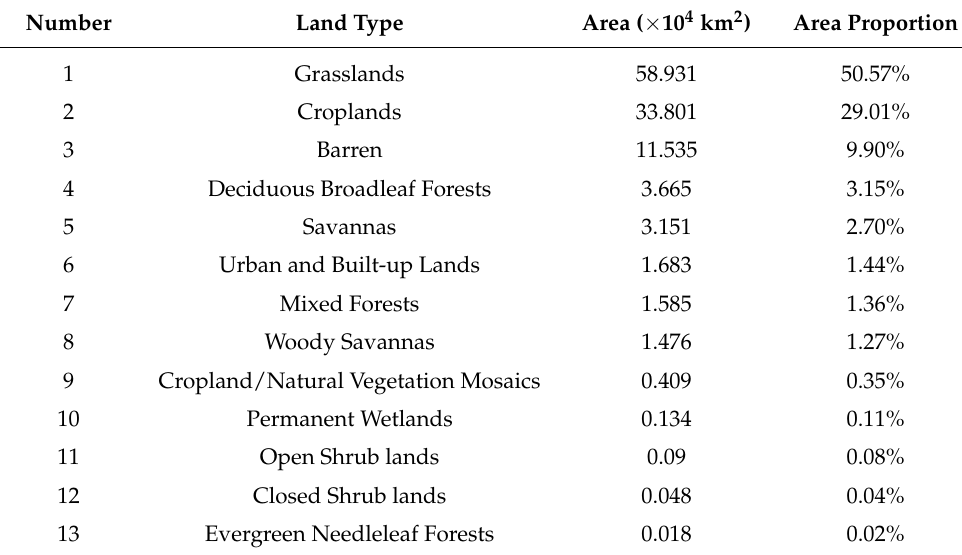
Figure 1. The Yellow River Basin and its land cover types. Table 1. Land cover type and proportion.